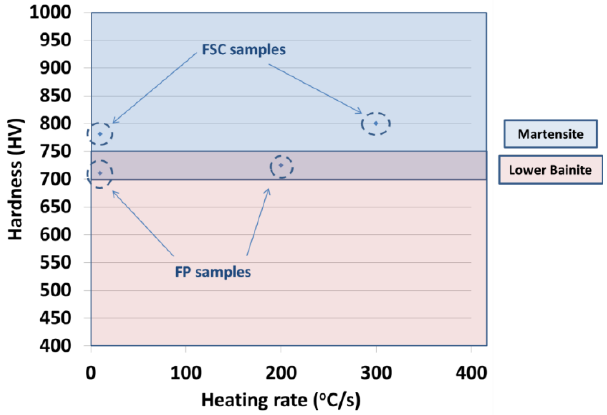
Figure 5. Hardness measurements of each sample in conjunction with heating rate. The hardness range of martensite (750–1000 HV) and lower bainite (400–750 HV) are based on the work of Wang et al. [36].